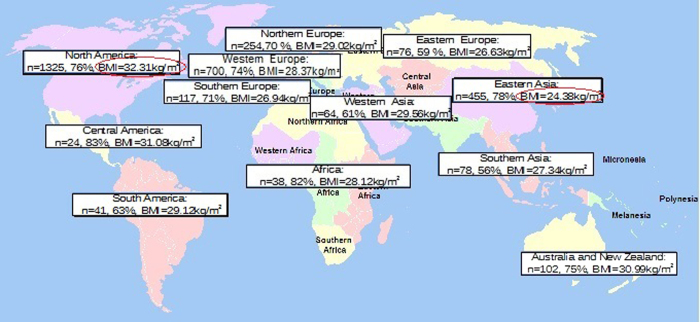
Geographic distribution of users.*United Nations geographical subregions (https://commons.wikimedia.org/wiki/File:United_Nations_geographical_subregions.png) is licensed under the Attribution-ShareAlike 3.0 Unported license. The license terms can be found on the following link: http://creativecommons.org/licenses/by-sa/3.0/”. **n = number of users, % female, initial BMI (kg/m2). ***The people located in different parts of Africa have been grouped into a single area since the sample size was small.